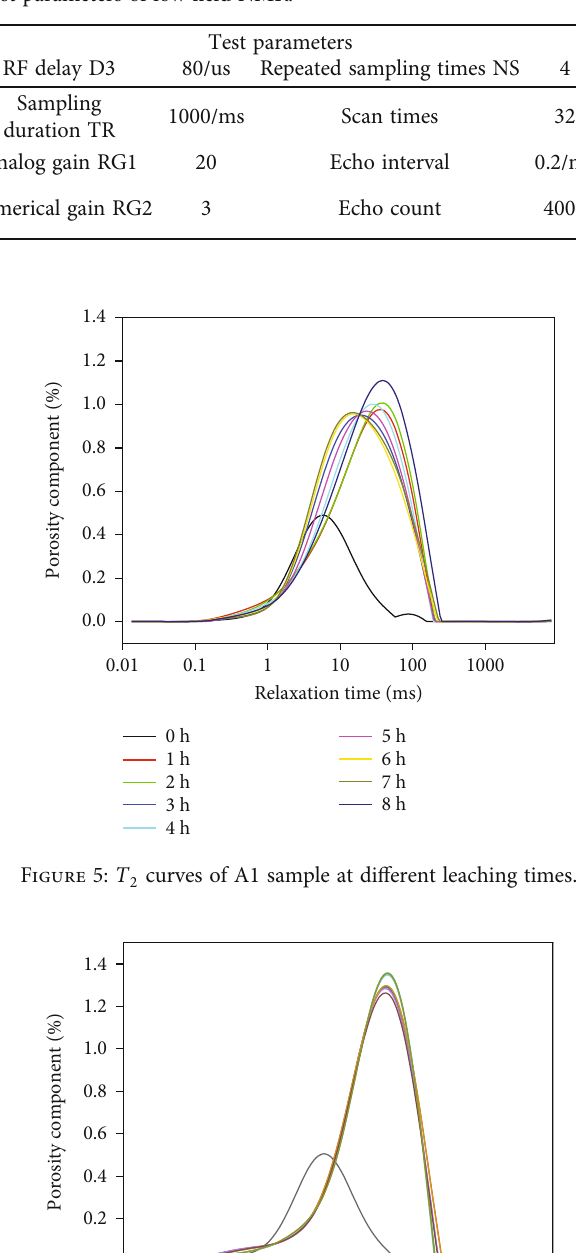
Figure 6: T 2 curves of A2 sample at di